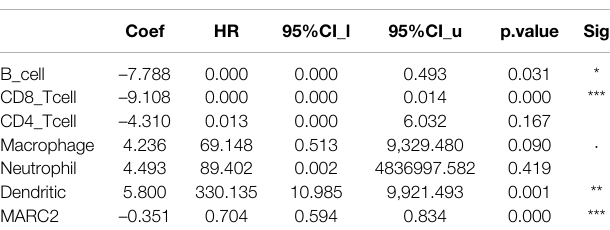
TABLE 2 | Cox regression